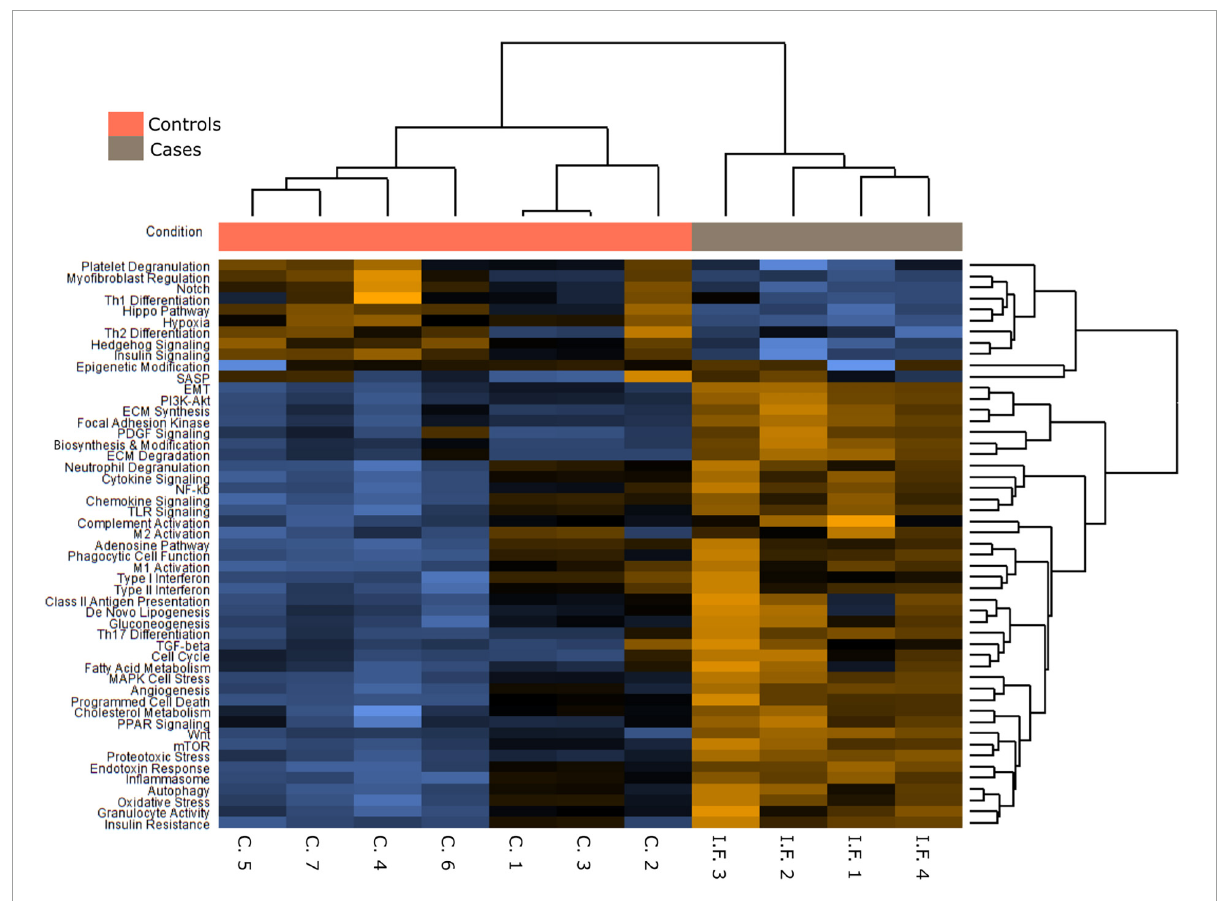
FIGURE11 Pathways differentially expressed in idiopathic pulmonary fibrosis (IPF) in comparison with normal